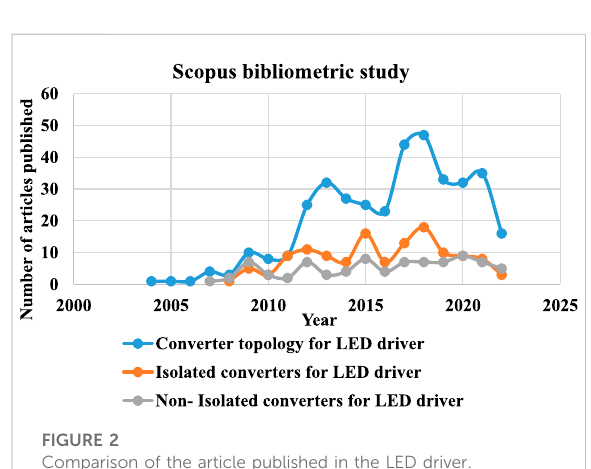
FIGURE 2 Comparison of the article published in the LED